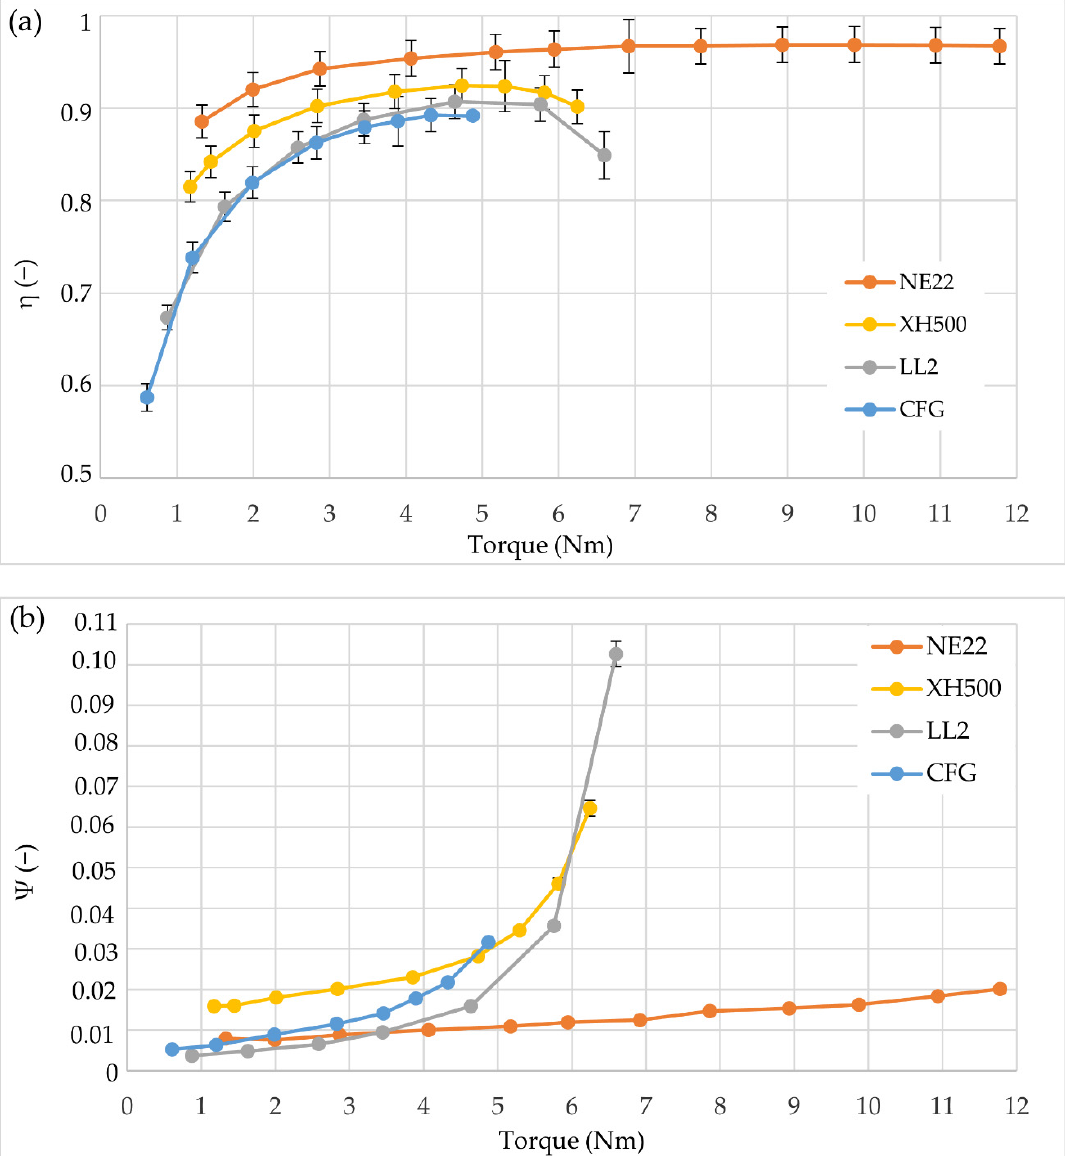
Figure 7. Variation characteristics of: ( a ) efficiency as a function of idler shaft torque ( b ) belt slippage as a function of torque at the idler shaft at 1000 rpm.